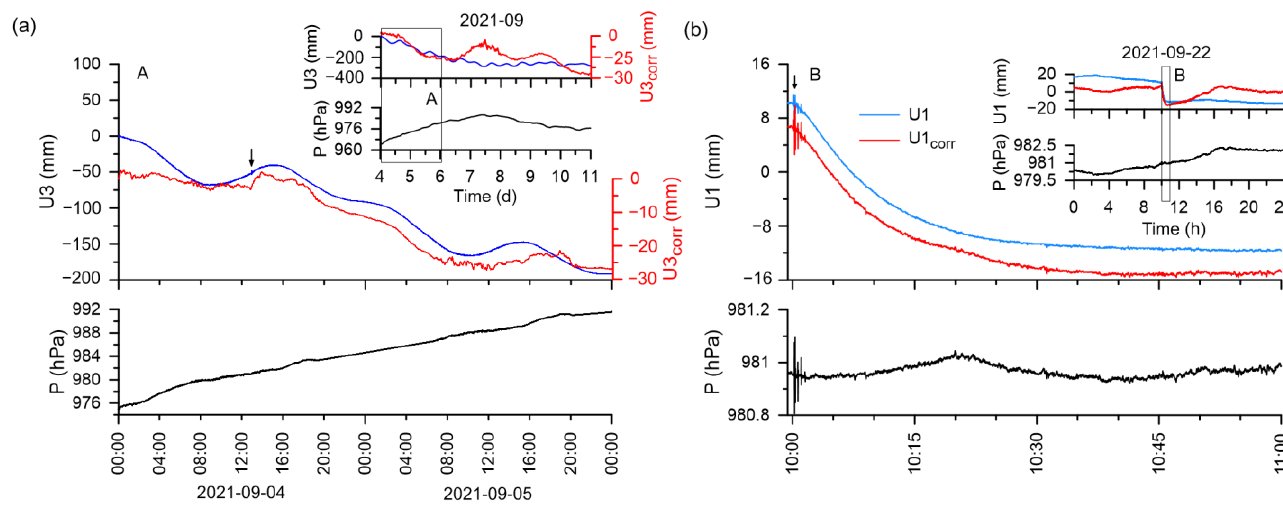
Figure 9. Diagrams of variations of postseismic lowering of water level and atmospheric pressure after the explosion in the mine on 4 September 2021 ( a ) and in the quarry on 22 September 2021 ( b ): blue line—initial level, red line—cleaned from the effects of atmospheric pressure and Earth’s tides. Arrows correspond to explosions.